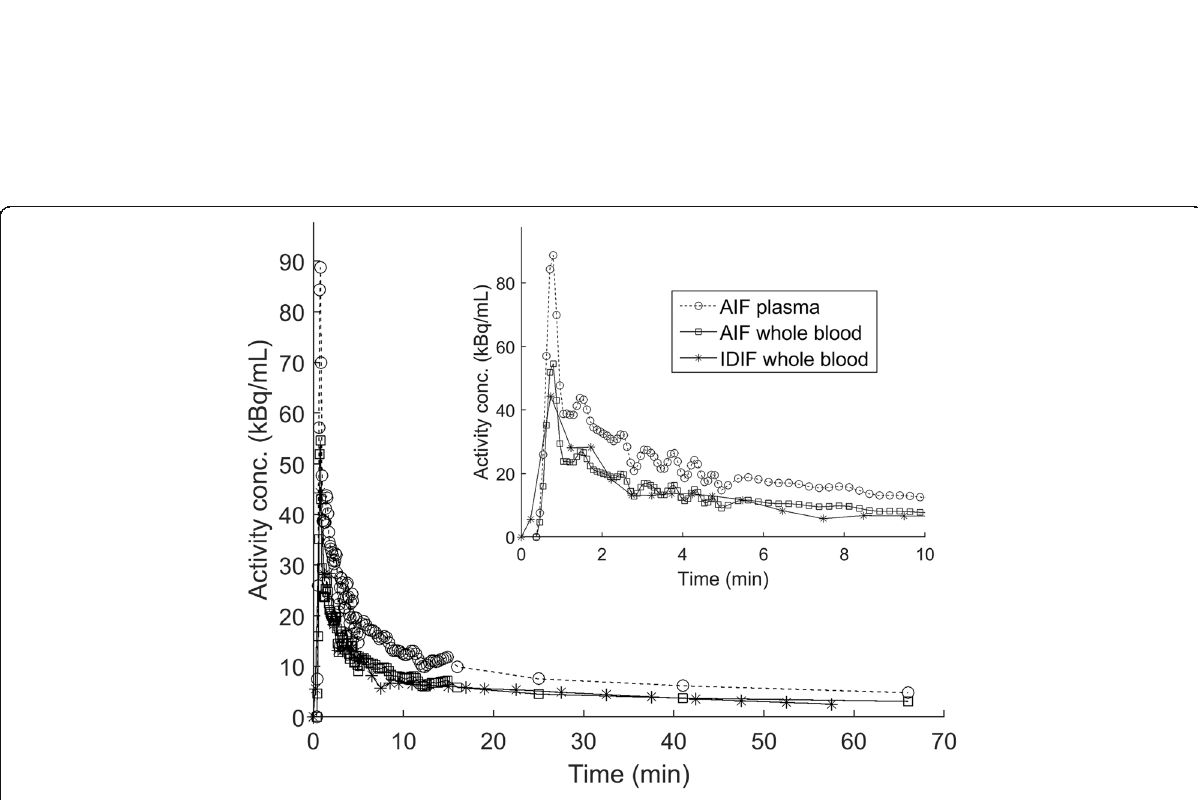
Fig. 4 Comparison of typical blood sampler plasma (AIF plasma) and whole blood (AIF whole blood) time-activity curves and corresponding image-derived whole blood curve (IDIF whole blood). Inset graph shows the first 10 min of the blood